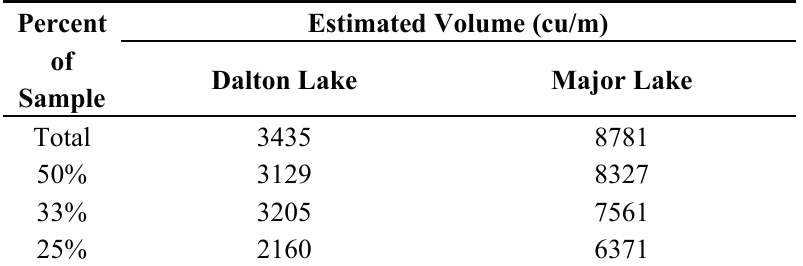
IDW interpolation from two Black Hills